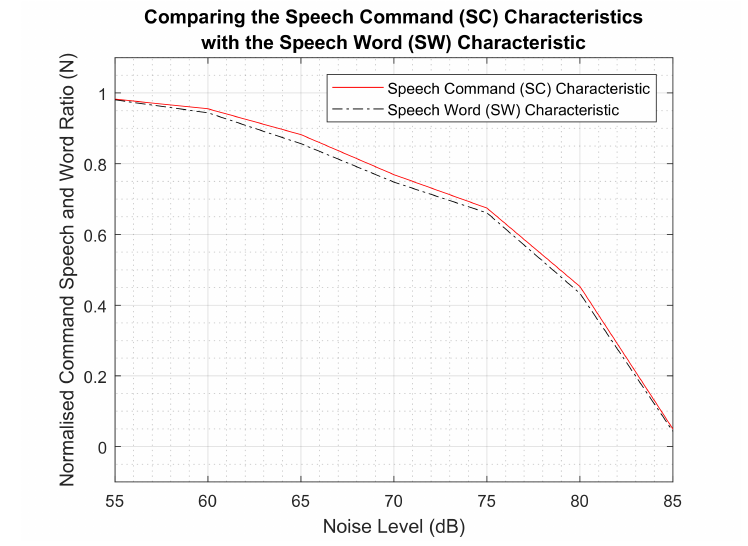
Figure 18. SC-SW trendline characteristic